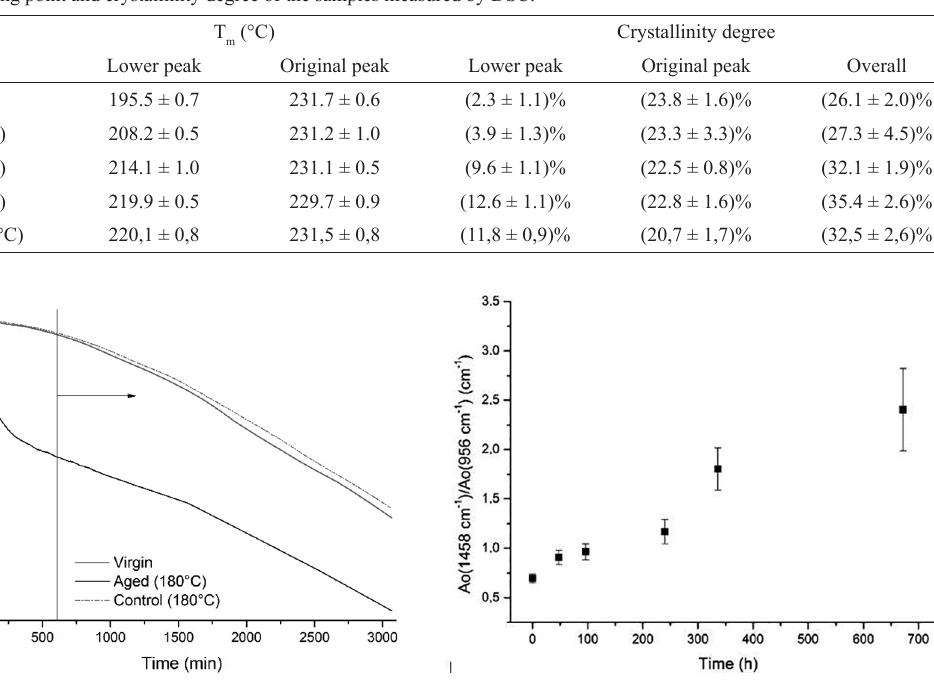
(1458 cm -1 )/A0(956 cm -1 ) ratio, relating Figure 8: Developing of A 0 to the increase in crystallinity during aging